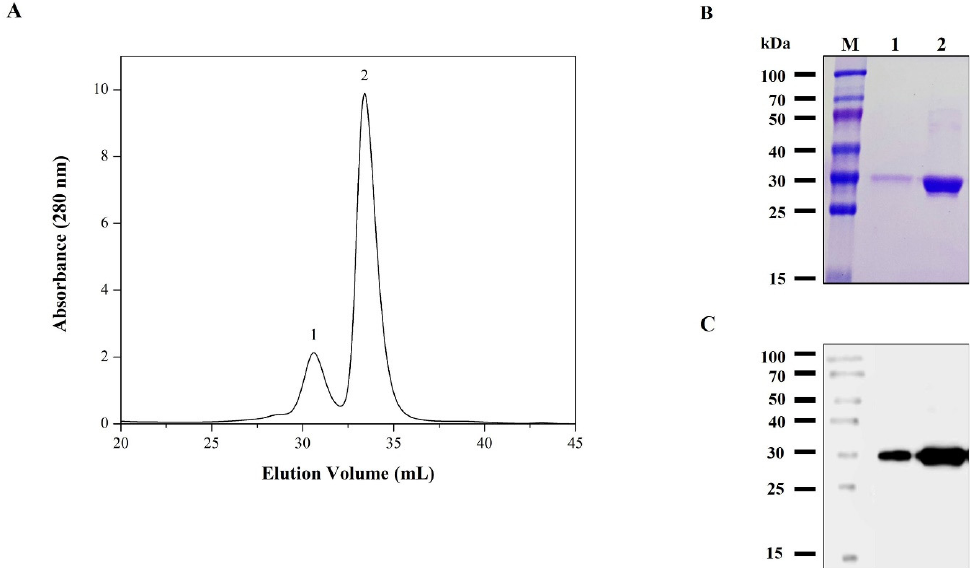
Figure 7. Size exclusion chromatography analysis of rRBD purified by IMAC. Chromatogram showing the elution profile of rRBD ( A ). The number indicates the peak containing rRBD dimer (1) and monomer (2). The peaks were analyzed by reducing SDS-PAGE ( B ) and western blot developed with specific anti-S antibody ( C ). Lanes: M, protein marker; 1, peak 1; 2, peak 2.